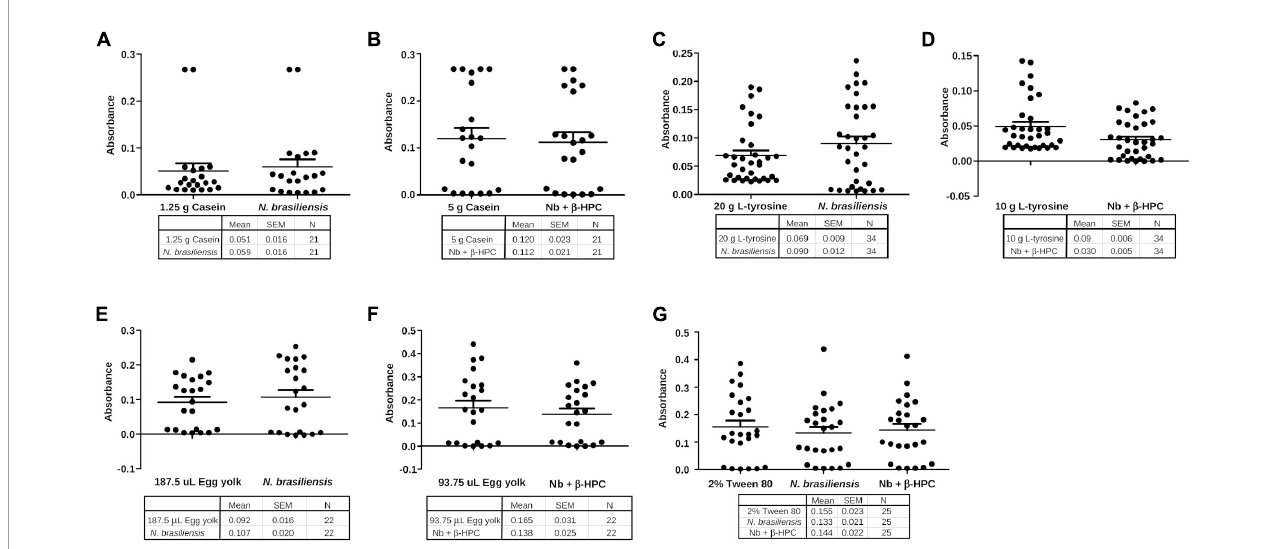
FIGURE9 Grouping of data of the hydrolysis of N. brasiliensis within the calibration curve. (A) Hydrolysis of N. brasiliensis casein compared to calibration curve 1:16 dilution, corresponding to 1.25 g. (B) N. brasiliensis + β -HPC casein hydrolysis was close to the calibration curve 1:4 corresponding to 5 g. (C) The hydrolysis of N. brasiliensis on L-tyrosine approached the initial amount of the calibration curve (20 g). (D) N. brasiliensis + β -HPC hydrolysis approached a dilution of 1:2 of L-tyrosine from the calibration curve (10 g). (E) In egg yolk hydrolysis by N. brasiliensis , the dilution was 1: 8. (F) The hydrolysis of egg yolk from N. brasiliensis + β -HPC was greater because it approached the highest dilution. (G) N. brasiliensis and N. brasiliensis + β -HPC species over Tween 80 hydrolysis showed similarities to the 2% calibration curve; it represented the initial concentration to be